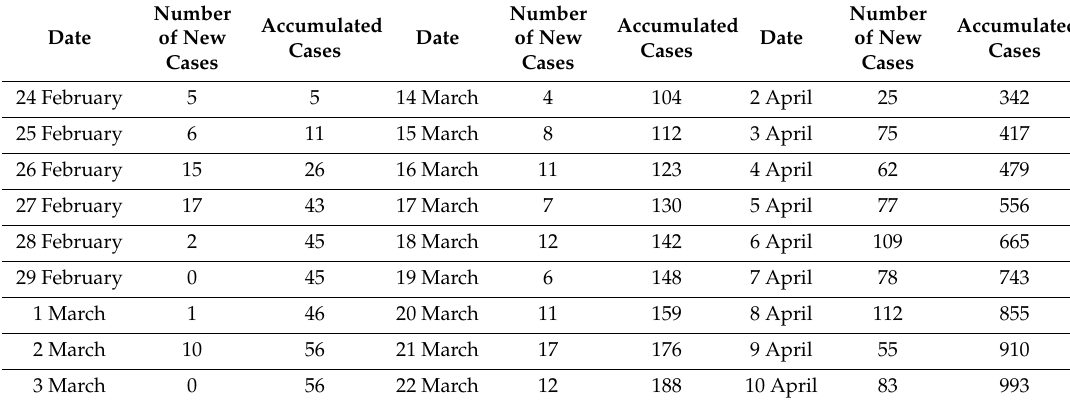
Table 1. Number of newly reported novel coronavirus 2019 (COVID-19) cases in Kuwait from